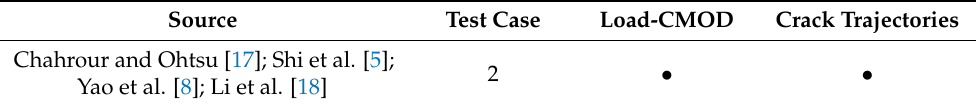
Table 4. Benchmark information availability considering conventional and enhanced boundary elements.